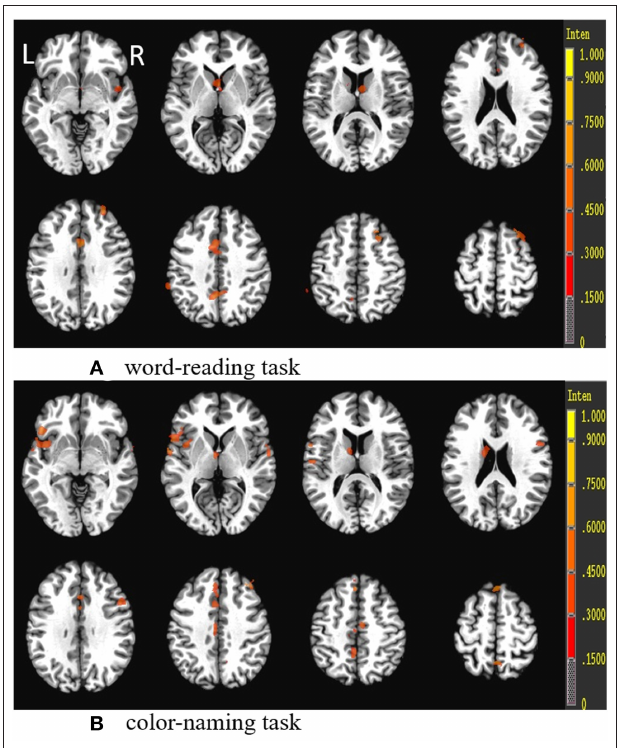
FIGURE 5 | Group differences (control group vs. SCH group) in the Stroop tasks (word-reading task and color-naming task). R, Right; L,